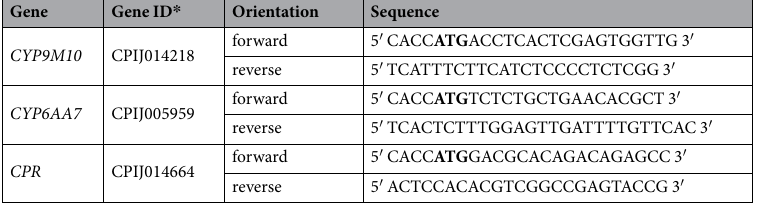
Table 3. Primers used for cloning P450 genes and CPR . * https://www.vectorbase.org/organisms/culex- County and Mobile County, AL 36 ; S-Lab is an insecticide susceptible strain kindly provided by Dr. Laura Harrington (Cornell University, Ithaca, NY). HAmCq G8 has a 2700-fold higher resistance to permethrin com- pared with S-lab. All the mosquitoes were reared at 25 ± 2 °C under a photoperiod of 12: 12 (L: D) h (insec- tary conditions) and fed blood samples from horses (Large Animal Teaching Hospital, College of Veterinary Medicine, Auburn University, Auburn, AL). Construction of pENTR ™ expression plasmids to obtain C YP9M10 , CYP6AA7 and CPR genes. Total RNA was extracted from 4 th instar larvae of HAmCq G8 using the acidic guanidine thiocyanatephenol-chloroform method 50 . The DNA was removed from the total RNA of each mosquito sam- ple using DNase (TURBO DNA-free, Ambion) and the DNA-free total RNA was reverse-transcribed to cDNA using a Transcriptor First Strand cDNA Synthesis kit (Roche) and odigo-dT primer following the manufac- turer’s instructions. The gene-specific primers used for cloning the complete reading frames of the CYP9M10 , CYP6AA7 and CPR genes were designed according to the Cx. quinquefasciatus genome sequence 1 (https://www. vectorbase.org/organisms/culex-quinquefasciatus) (Table 3). Four nucleotide bases CACC were added to the 5 ′ end forward primer (immediately upstream of the ATG transcription start codon. Table 3), enabling the P450 products to be directly cloned into the pENTR ™ TOPO ® vector (Invitrogen) by annealing to the CACC sequence ® competent E. coli . pENTR ™ plasmids with CYP9M10 , CYP6AA7 , or CPR and purified using the PureLink HQ Mini plasmid purification Kit (Invitrogen). Orientation of the inserted genes was tested